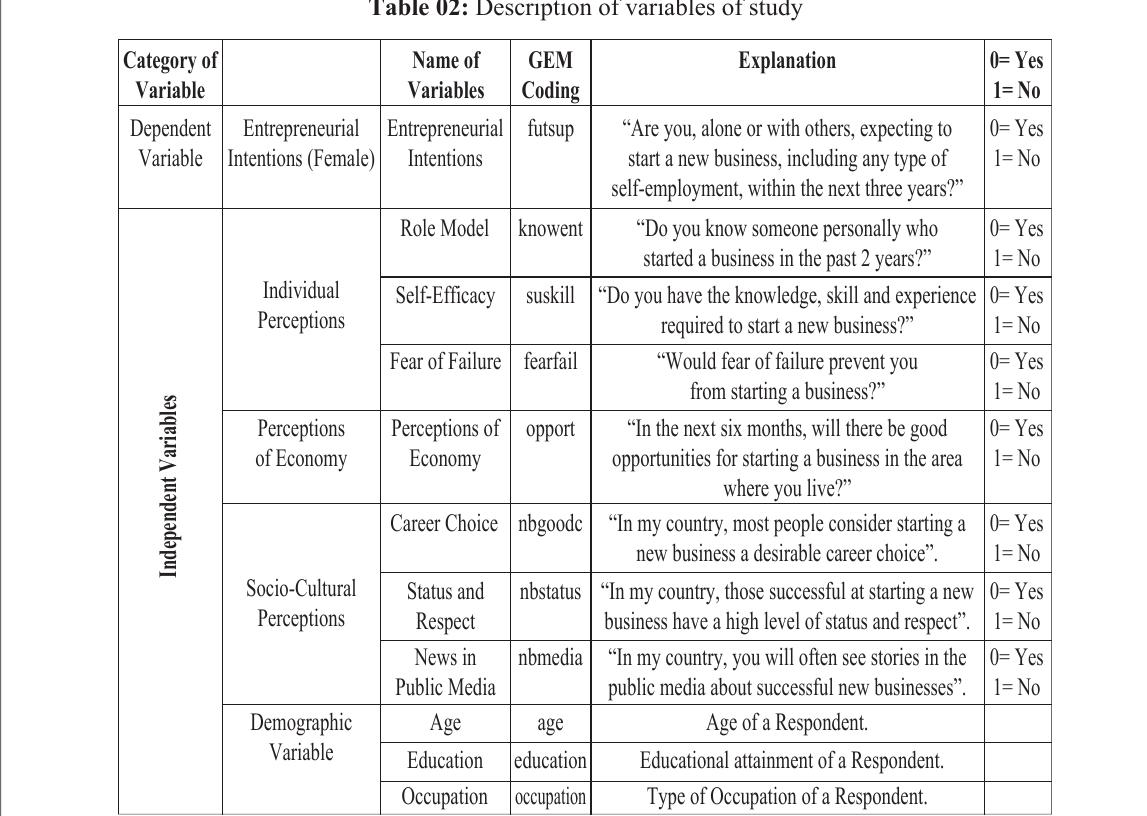
Table 02: Description of variables of